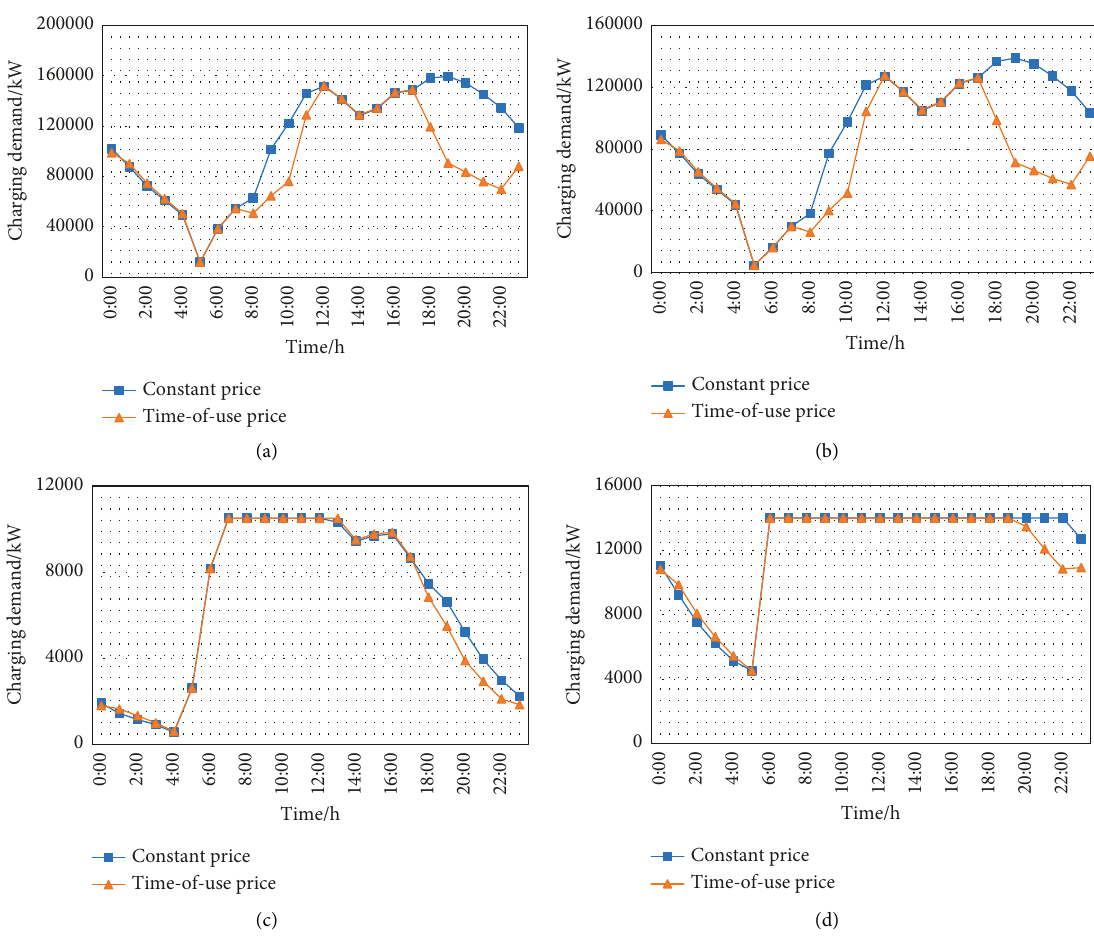
Figure 4: Comparison of charging demand distribution in different charging price scenarios. (a) Overall charging demand distribution. (b) Charging demand distribution in residential areas. (c) Charging demand distribution in work areas. (d) Charging demand distribution in other